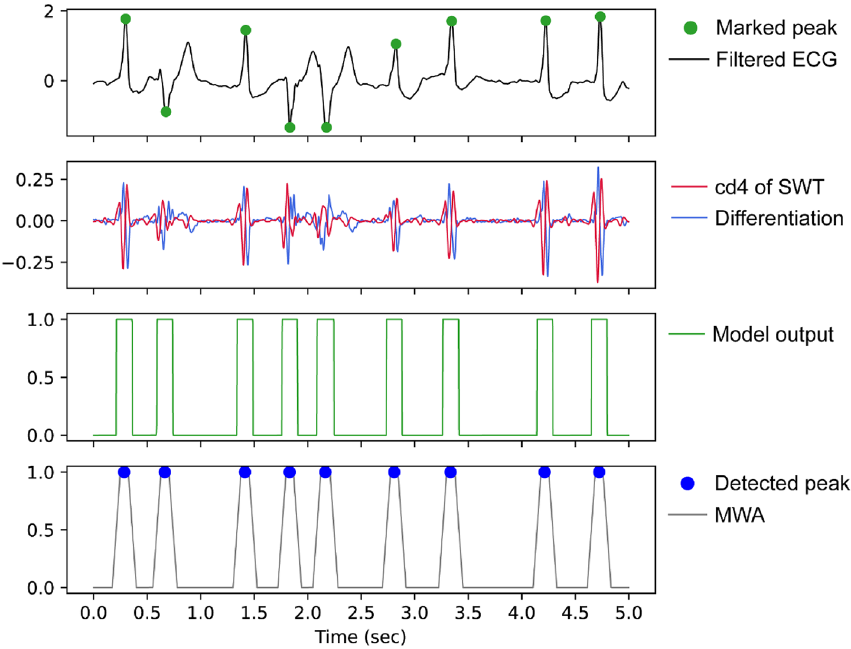
Figure 4. An example of peak localization in patient 114 of the MIT-BIH database. cd4 detail coefficient of level 4 SWT decomposition; MWA moving window average.